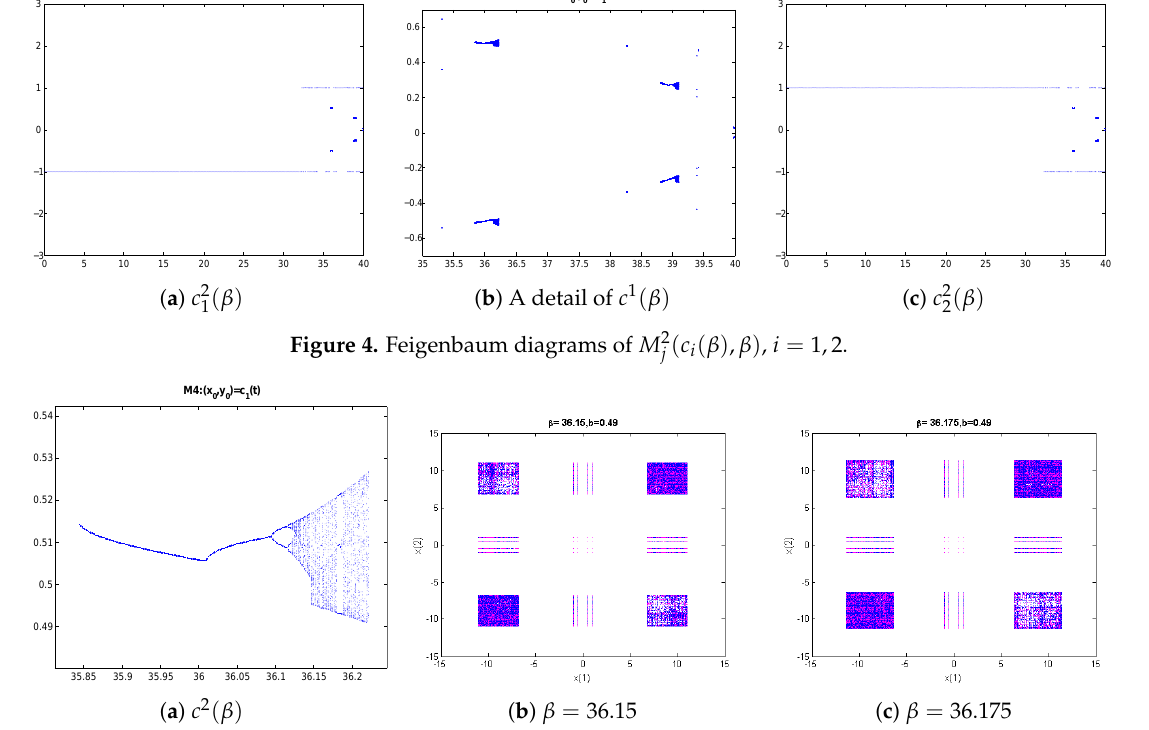
Figure 5. Strange attractors of M42 class for β values in the period-doubling cascade